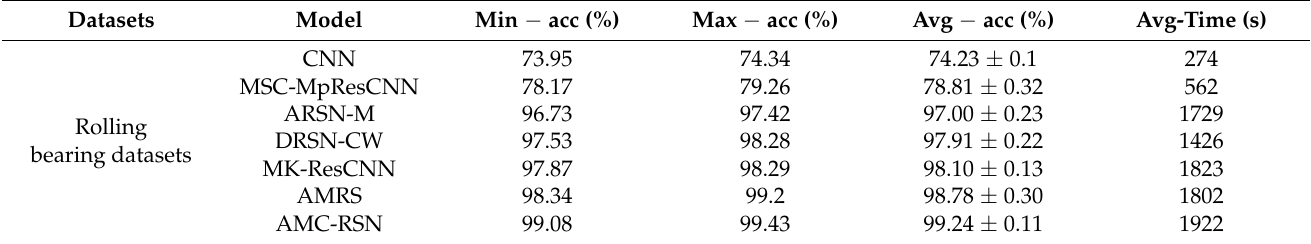
Figure 7. These three pictures show the front, back, and side of the test rolling bearing respectively. Table 2. Fault diagnosis results of rolling bearing.